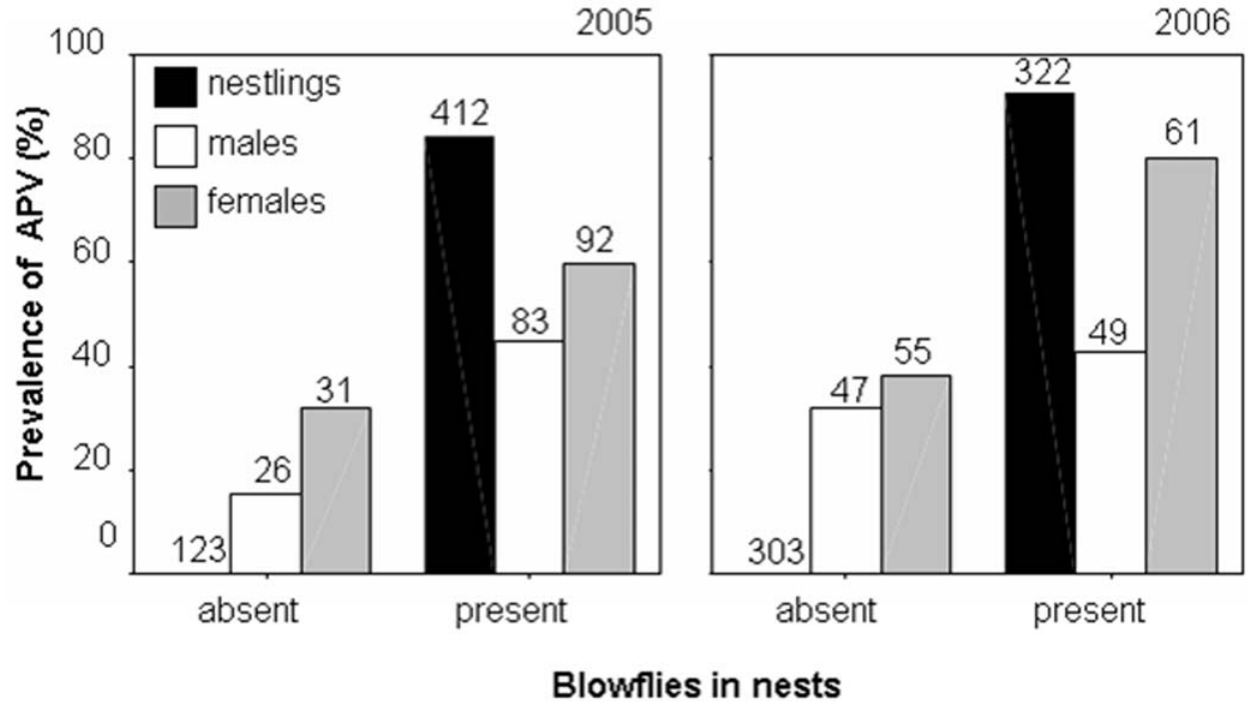
Figure 1. Prevalence of APV infections in blood of nestlings and adult pied flycatchers in relation to presence or absence of nest ectoparasitic blowflies. 2005 nestlings: Fisher’s exact test, P , 0.0001; adult males: x 2 1 =6.00, P =0.014; adult females: x 2 1 =5.99, P =0.014; 2006 nestlings: x 2 1 =531.74, P , 0.0001; adult males: x 2 1 =0.80, P =0.370; adult females: x 2 1 =19.74, P , 0.0001. The Yates’ correction for continuity was applied. Numbers above bars are sample sizes (numbers of individuals).